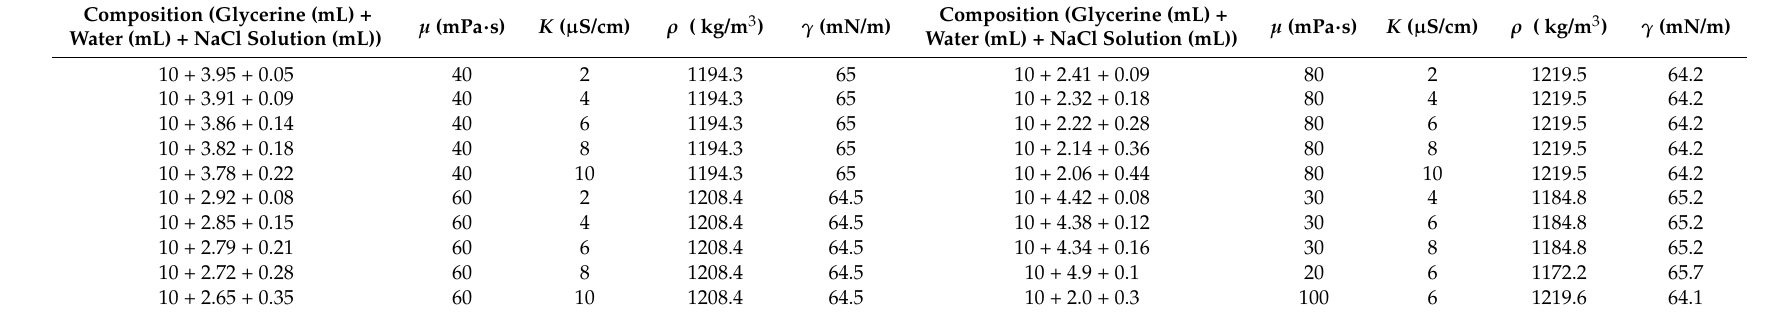
Table A1. The compositions and properties of the liquids used in the experiments.